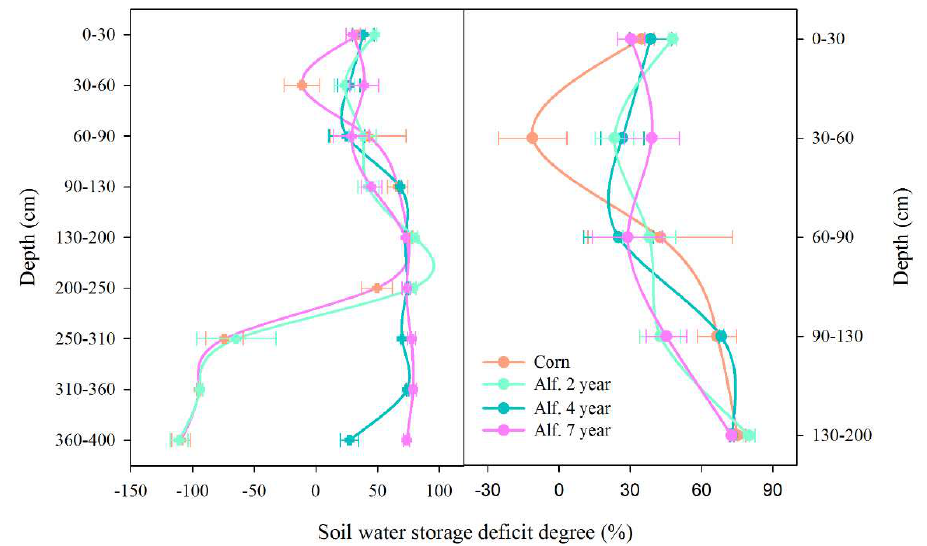
Figure 3. Soil water storage deficit degree of the cornfield and the two-, four- and seven-year-old alfalfa pastures at different soil thicknesses along the 0–400 cm soil layers. The figure on the right shows the detailed soil water storage deficit degree at the 0–200 cm soil layers.